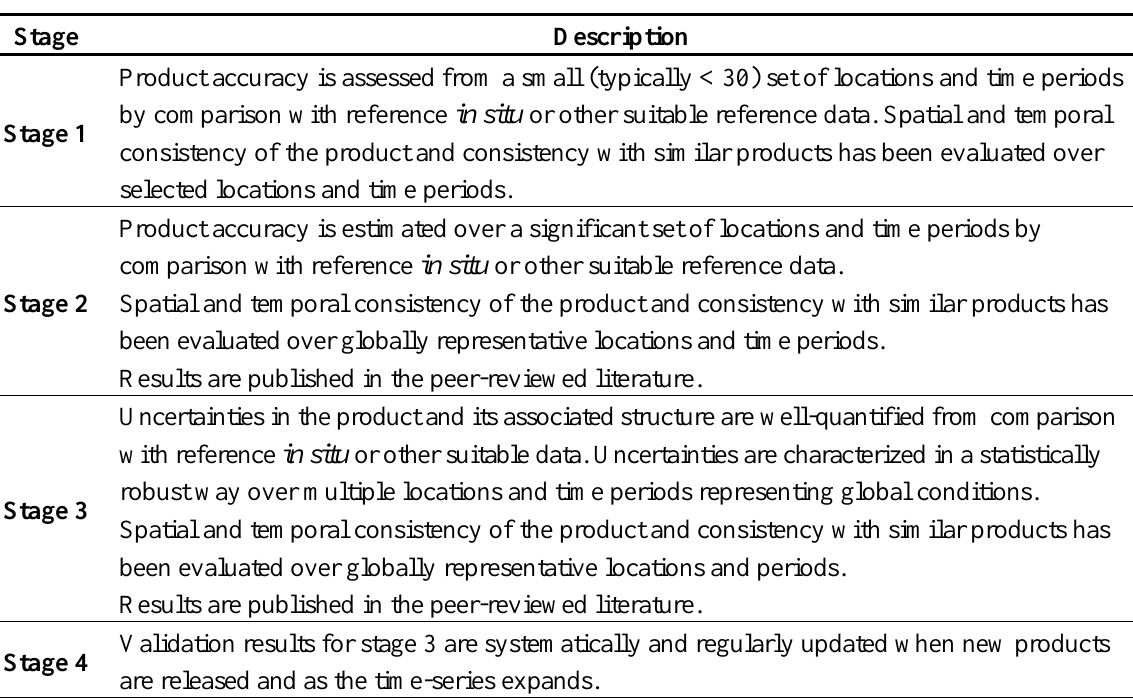
Table 1. The Committee for Earth Observation Satellites (CEOS) validation stages incorporating stage 4 validation that defines an operational component to ensure that land product time-series are systematically validated